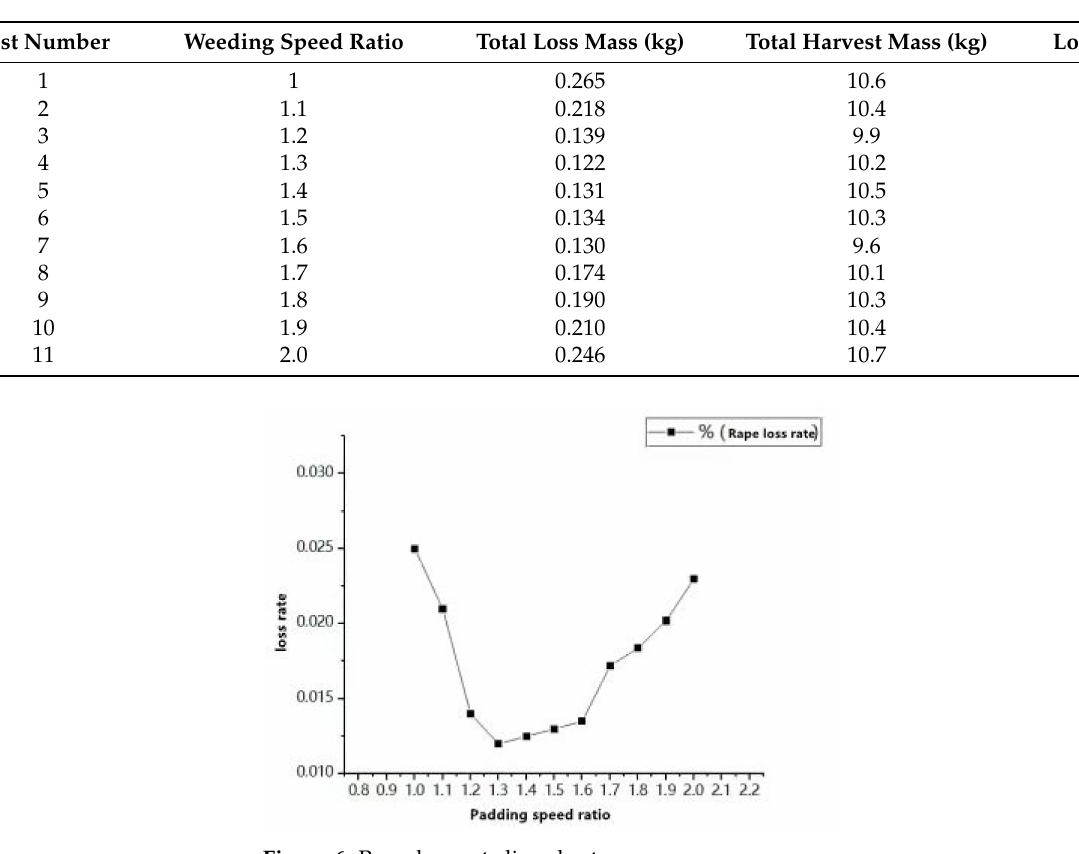
Table 3. Rape-loss-rate table.